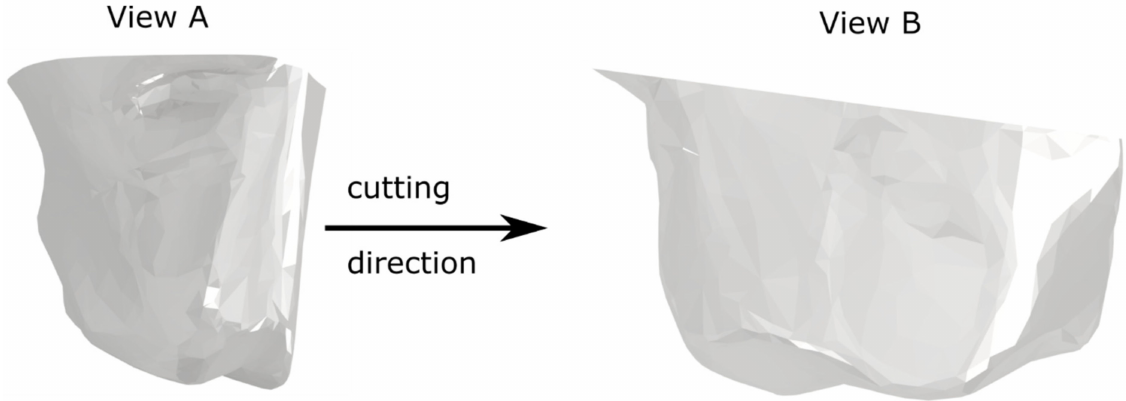
Figure 8. The cutting grain used for experimental validation of the numerical simulations.